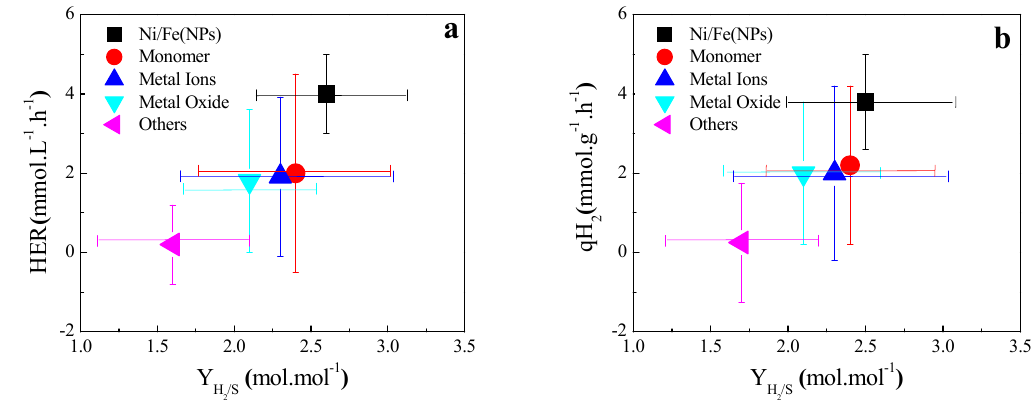
( b ) Figure 4. Data illustrating the mean and standard deviation of di ff erent metal additions, such as NPs, mental monomers, metal ions, metal oxides, and other metals on BHP during DF: ( a ) HER as a function of Y H2 / S ; ( b ) qH 2 as a function of Y H2 / S . Note: Others exclude reports using immobilized